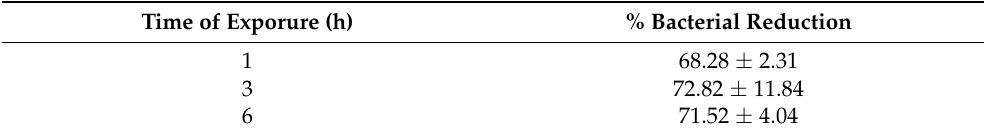
Table 5. Reduction percentage of E. coli after exposure on 10% wt TiO 2 /PDMS samples for different time